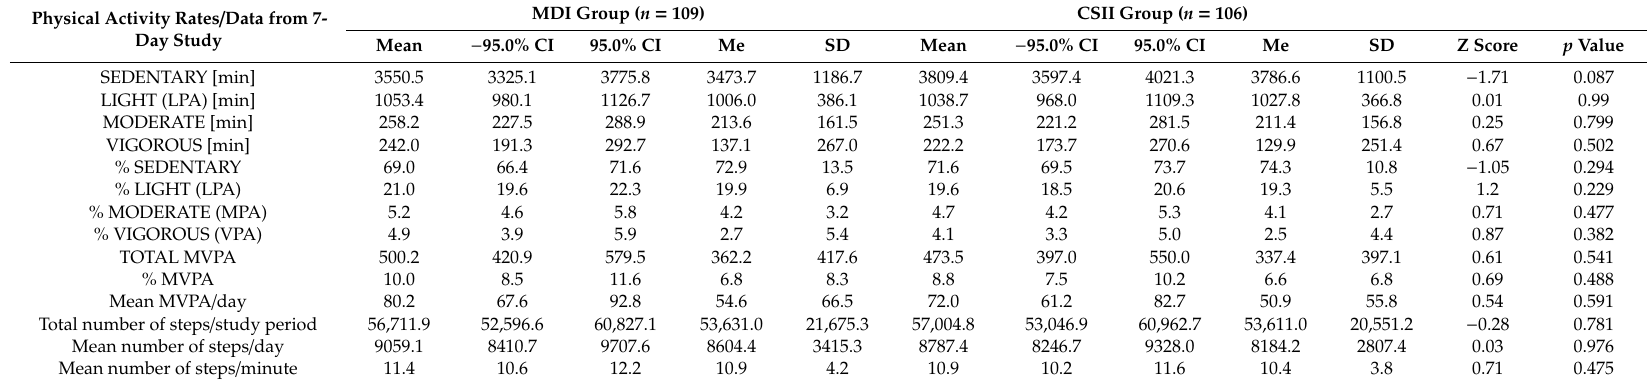
Table 2. Comparison of physical activity rates in the multiple daily injections (MDI) and continuous subcutaneous insulin infusion (CSII) groups. Physical Activity Rates / Data from 7- Day